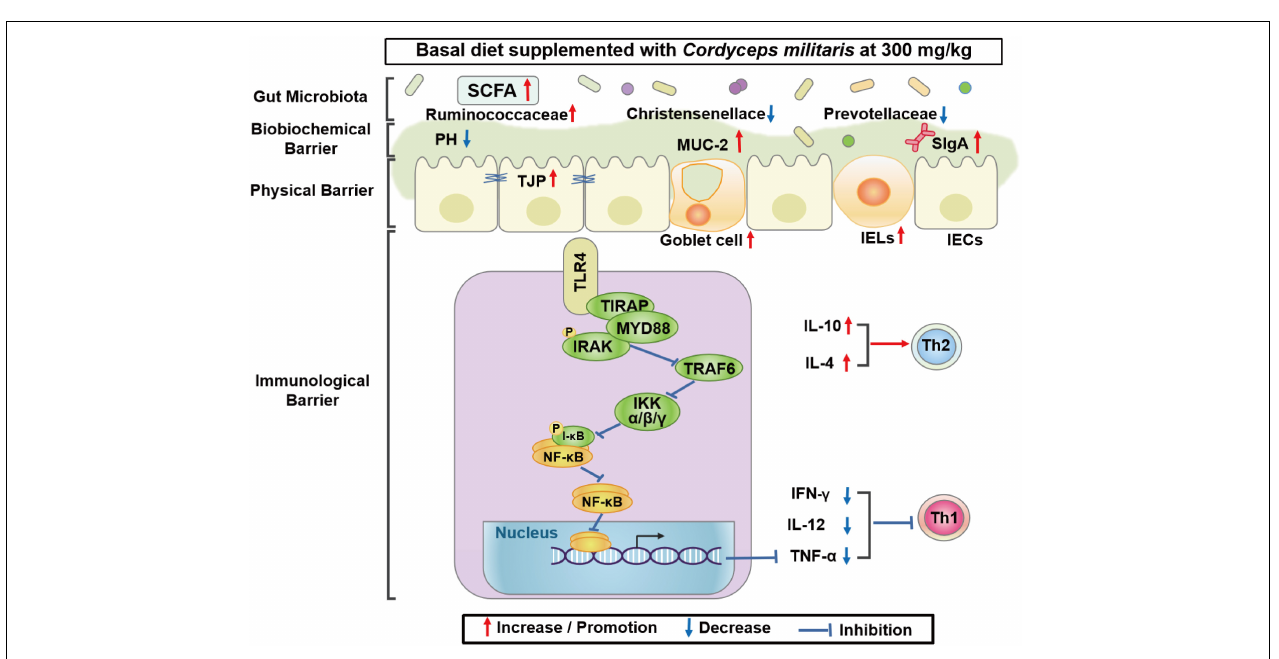
FIGURE 6 | CM promotes the production of SCFAs in the colonic digesta. (A) Concentrations of microbial fermentation metabolite SCFAs. (B) Spearman’s correlation test was used to analyze the correlation between colonic microbial composition related to SCFAs (acetate, propionate, and butyrate); red represents a positive correlation, and blue represents a negative correlation. (C) The pH value in the colonic digesta. Control, pigs fed a basal diet; CM, pigs fed the basal diet supplemented with CM at 300 mg/kg. Data are presented as the mean ± SEM ( n = 5). * P < 0.05, ** P < 0.01.